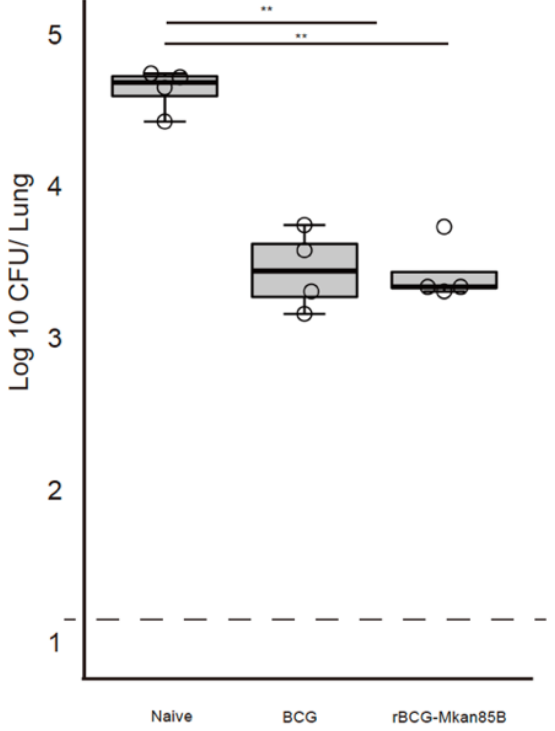
Figure 1. BCG or rBCG-Mkan85B vaccination protects against M. kansasii infection. The CB6F1 (H2b/d) mice were either left unimmunized or immunized with BCG or rBCG-Mkan85B for 6 weeks, followed by intratracheal infection with a virulent M. kansasii strain. The mice were sacrificed at 6 weeks after M. kansasii infection. The immunization schedule is shown Figure S1A. The number of M. kansasii in individual mouse lungs was analyzed using the colony assay method. The data represent two independent experiments with three to four mice per group. The detection limit for bacilli in the tissue homogenate was 15 CFU. The error bars represent the SD. ** p < 0.01.